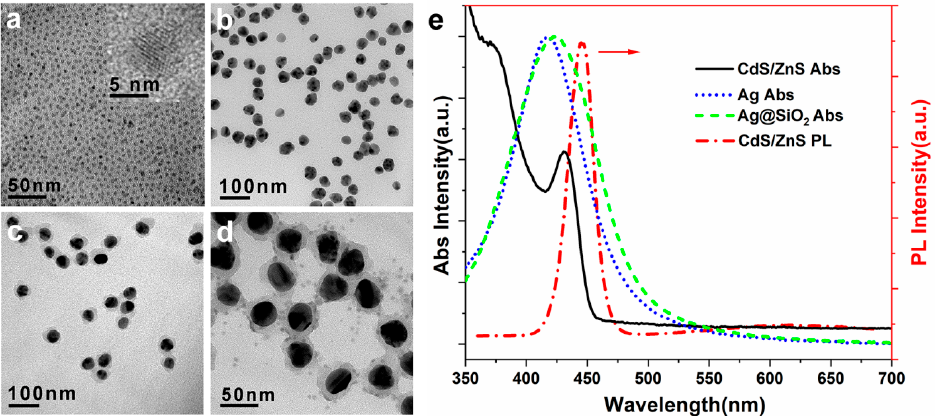
Figure 2. TEM images of the CdS/ZnS core/shell QDs ( a ), Ag nanoparticles ( b ), Ag@SiO 2 core/shell nanoparticles with SiO 2 shell thickness of about 10 nm ( c ), and Ag@SiO 2 @CdS/ZnS composite nanoparticles ( d ). ( e ) Absorption (Abs) spectra of Ag nanoparticles, Ag@SiO 2 nanoparticles, CdS/ZnS QDs, and photoluminescence (PL) spectrum of CdS/ZnS QDs, respectively.